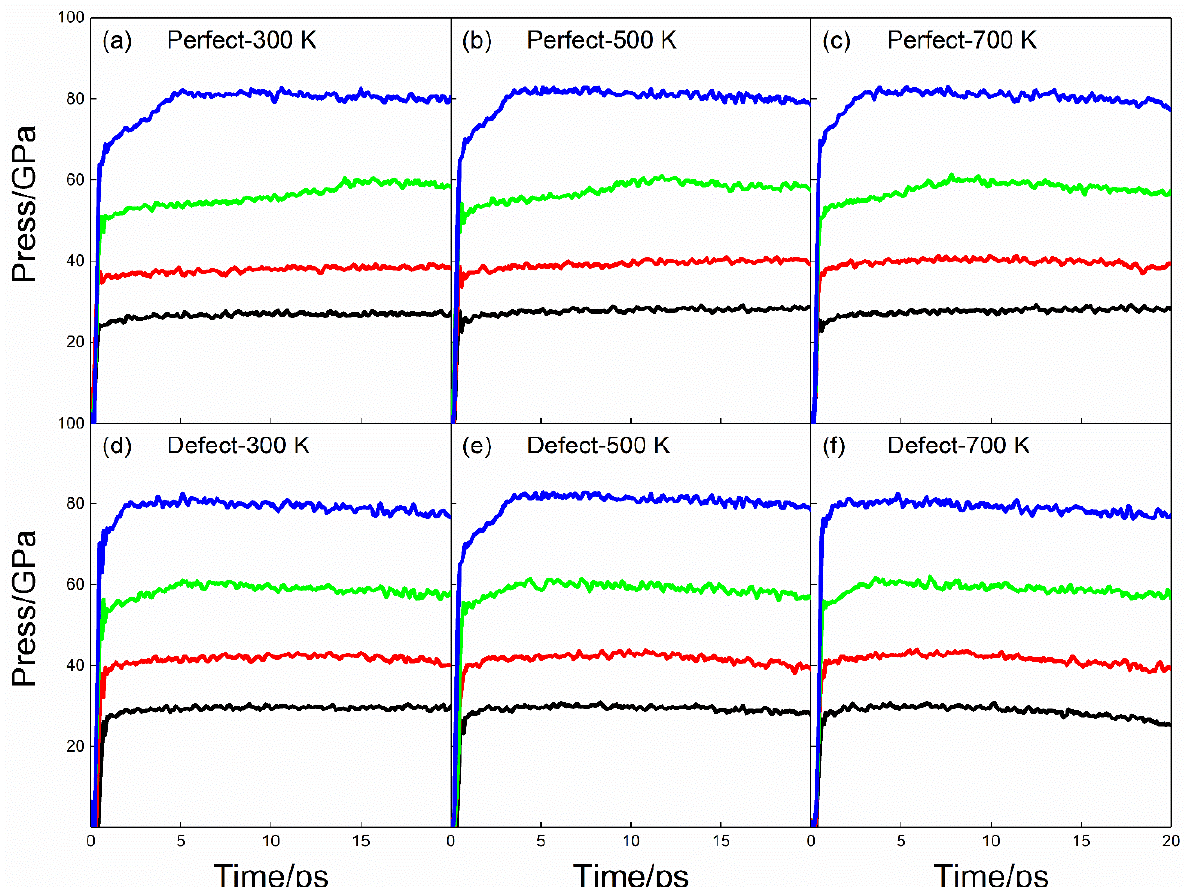
Figure 2. Press evolution curves for the shock compression. ( a – c ) correspond to perfect PETN crystal with preheating temperatures 300 K, 500 K, and 700 K; ( d – f ) correspond to defective PETN crystal with preheating temperatures 300 K, 500 K, and 700 K; black, red, green, and blue line correspond to shock velocities, U s = 7 km·s − 1 , 8 km·s − 1 , 9 km·s − 1 , 10 km·s − 1 .